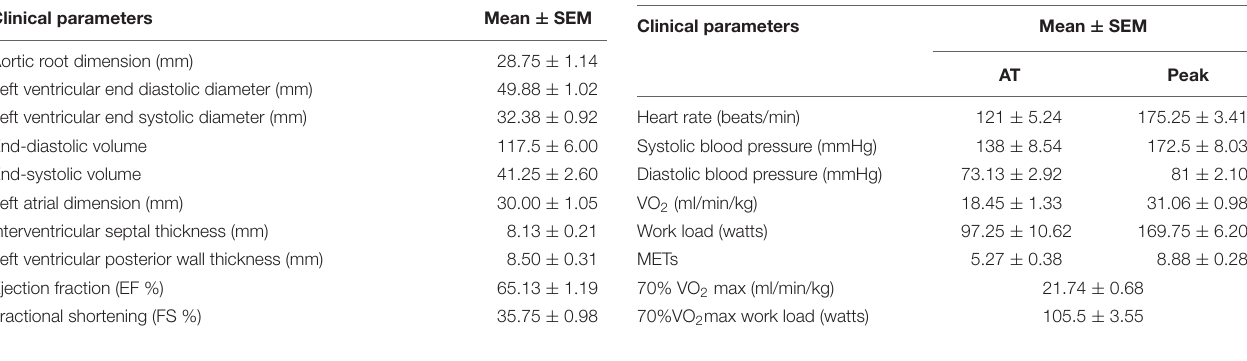
TABLE 2 | General echocardiographic indexes of